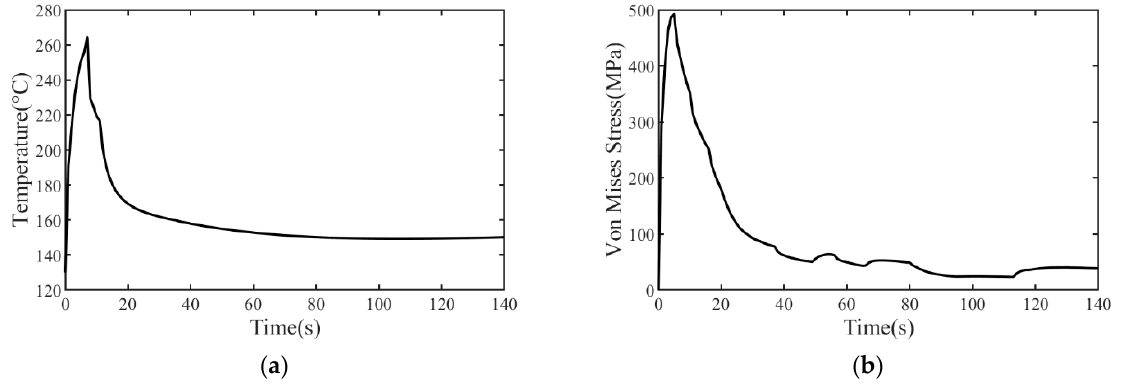
( b ) Figure 5. Comparisons between experiment and simulation of shot sleeve: ( a ) temperature; ( b ) deformation. In Figure 5, for both the temperature and deformation data, the trends between the experimental and simulated results are nearly consistent, and the errors are within a rea- sonable range, indicating the accuracy of the FE model. Simultaneously, the errors be-